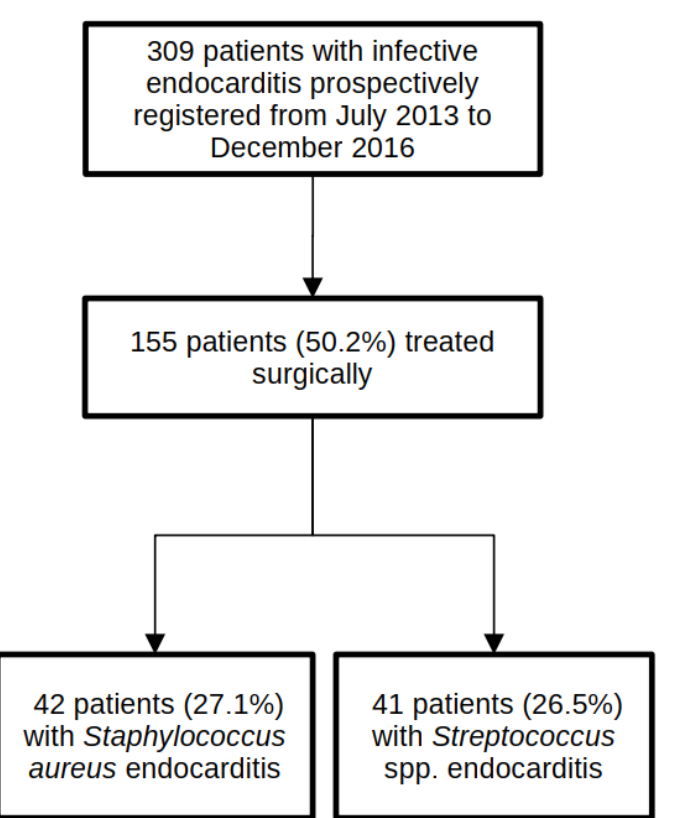
Figure 1. Flow diagram showing study population selection.